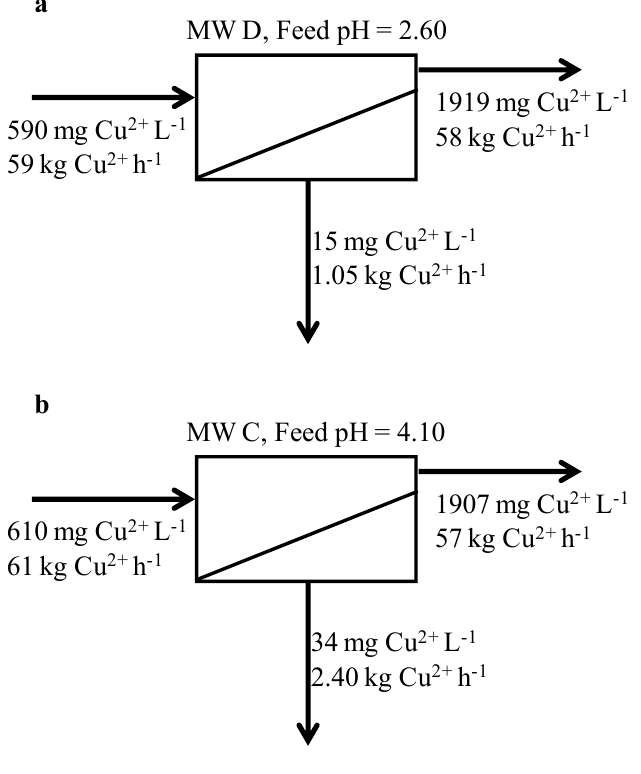
Figure 5. Copper mass balance calculated for ( a ) MW D at pH = 2.60 and for ( b ) MW C at pH = 4.10. The feed flow rate and volumetric recovery are fixed at 100 kL h − 1 and 70%,